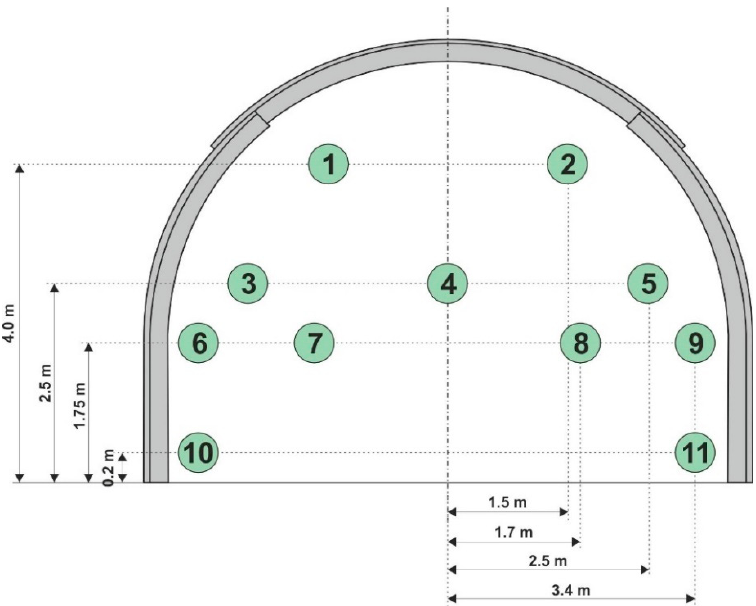
Figure 16. Location of measurement points in the cross-section for the analysis of methane concen- tration within the roadway.